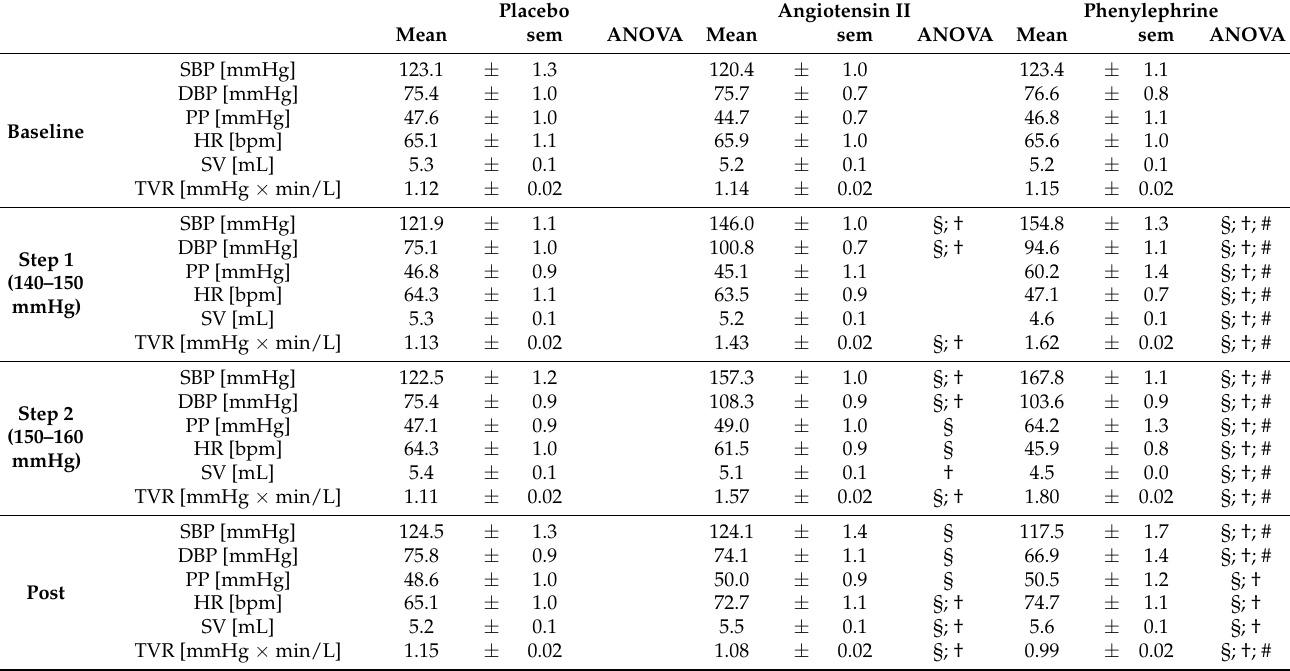
Table 1. Peripheral blood pressure (BP) with systolic (SBP), diastolic blood pressure (DBP) and pulse pressure (PP), heart rate (HR), cardiac stroke volume (SV) and total vascular resistance (TVR) of all three conditions at different recording periods. Comparison of different periods within condition (ANOVA) § p < 0.05. Comparison of corresponding periods between conditions (ANOVA) † p < 0.05 for Ang II or PE vs. placebo, # p < 0.05 for Ang II vs. PE.